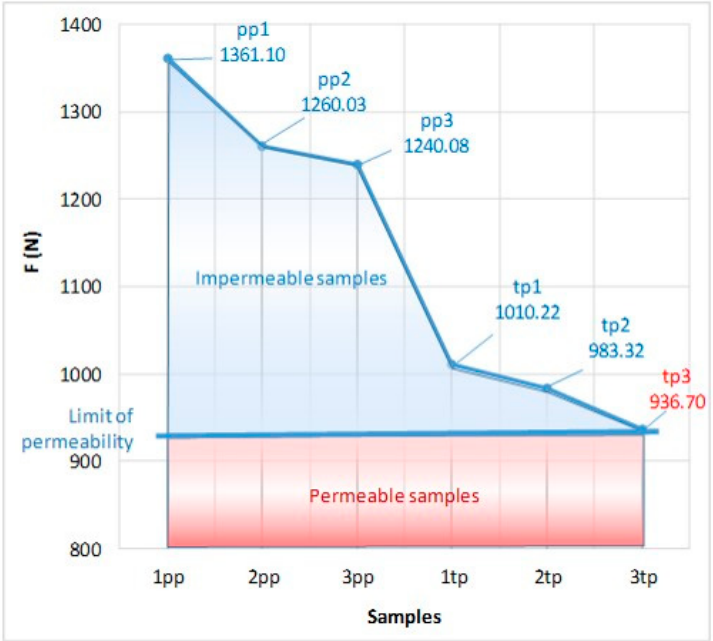
Figure 10. Bursting of woven fabrics according to the pattern, with surfaces of permeability/imper- meability highlighted, and the limit of permeability of microorganisms through the fabric.